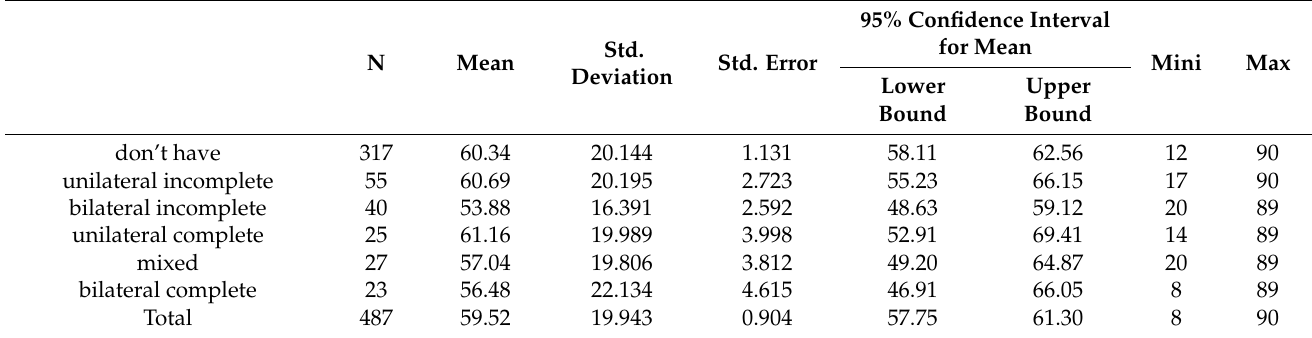
Table 5. Average age compared by type of ponticulus posticus.